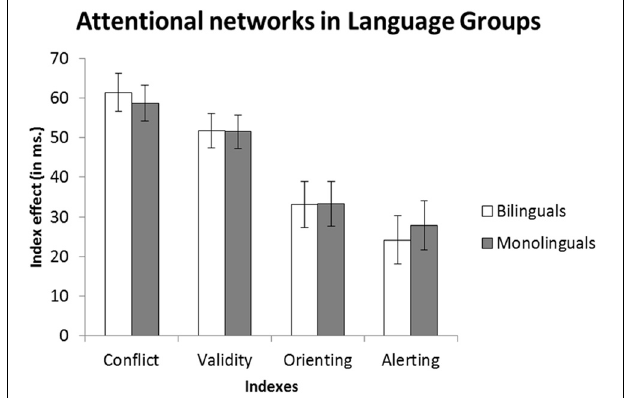
FIGURE 1 | Comparison of indexes across Language Groups.